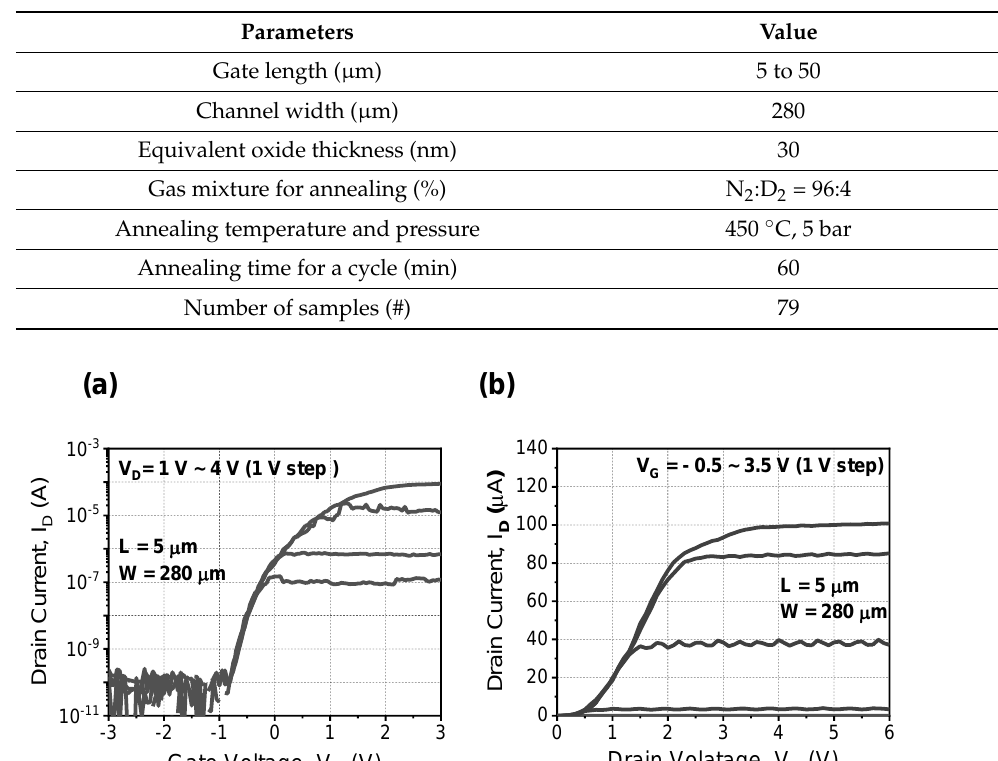
Figure 2. Measured ( a ) I D -V G and (b ) I D -V D characteristics of fabricated TV device before deuterium annealing.